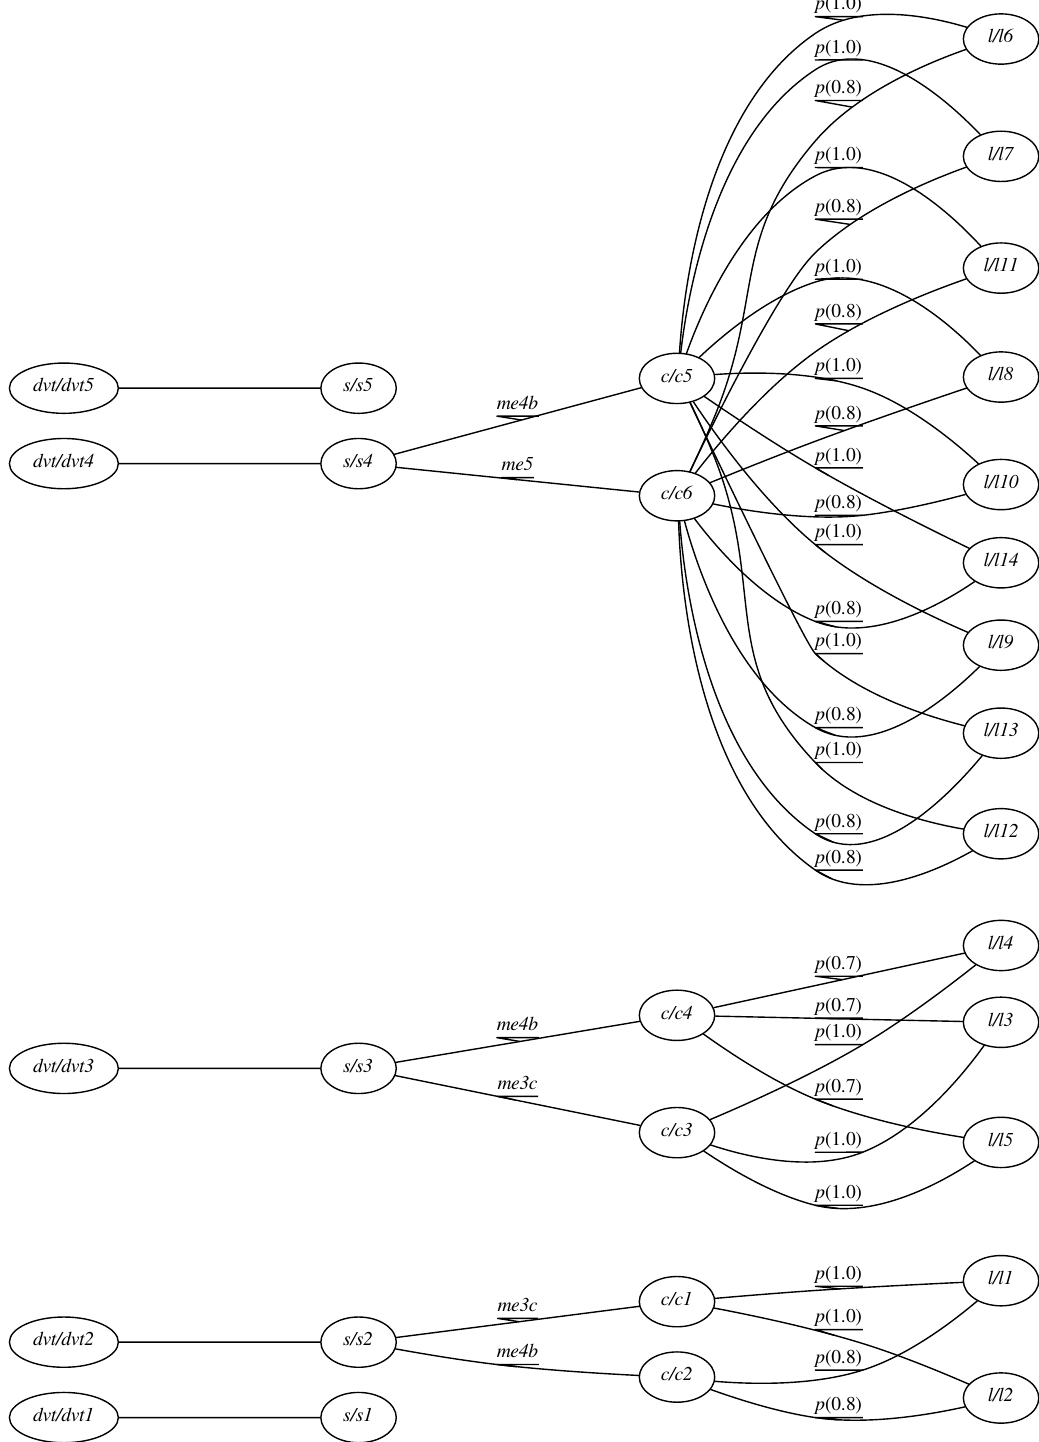
Figure 9. An example intersection, Krakow, Poland; CAG Ψ complying with the Ψ (structure)